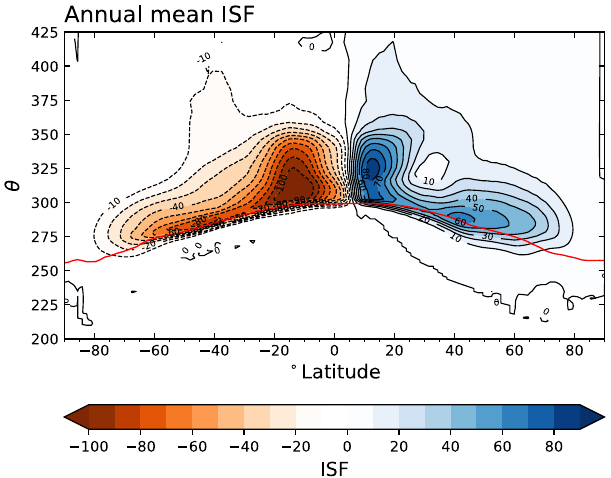
Fig. 1 Annual mean isentropic mass stream function for the period 1979 – 2017. The direction of the circulation is clockwise in the NH (orange) and anticlockwise in the SH (blue), represented by positive and negative dry isentropic stream function values, Ψ ( 10 9 kg s − 1 ), respectively. The red line shows the average median surface potential